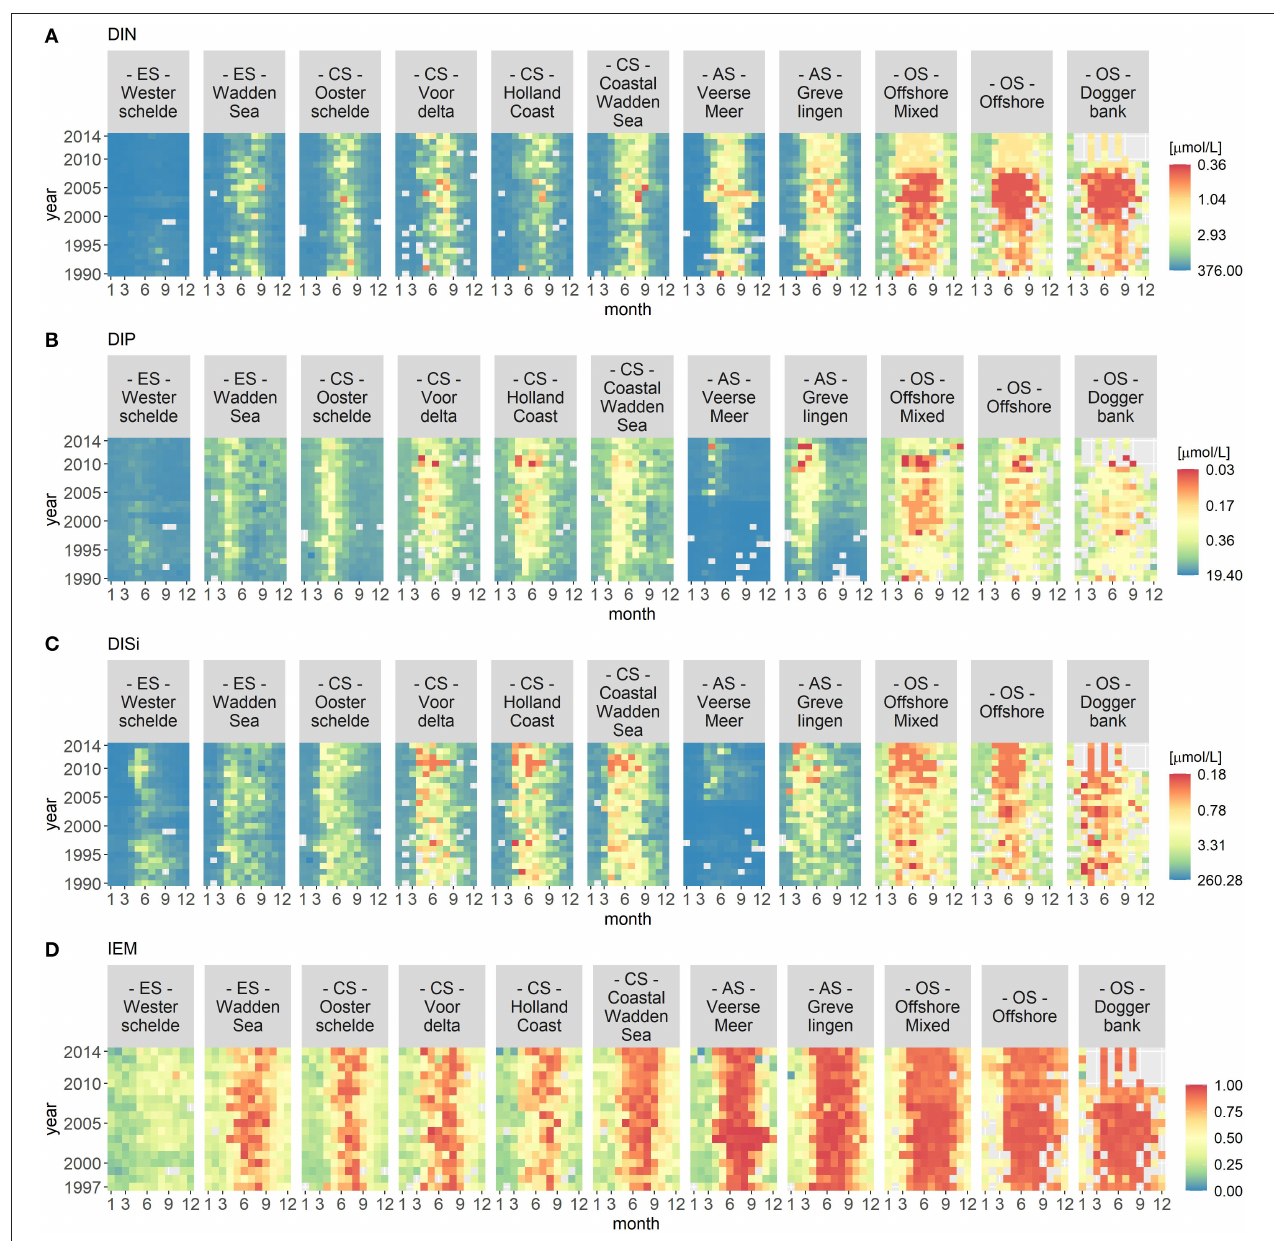
FIGURE 2 | Monthly median of nutrient concentrations for DIN (A) , DIP (B) , and DISi (C) as well as the IEM (index of ecosystem maturity – D ) for each location class per year. The nutrient concentrations were hyperbolically transformed. The location classes are grouped into estuary (ES), coastal (CS), anthropogenically modified (AS), and offshore systems (OS). The figures display gradients (left to right) from the estuary systems (ES) to the offshore systems (OS).